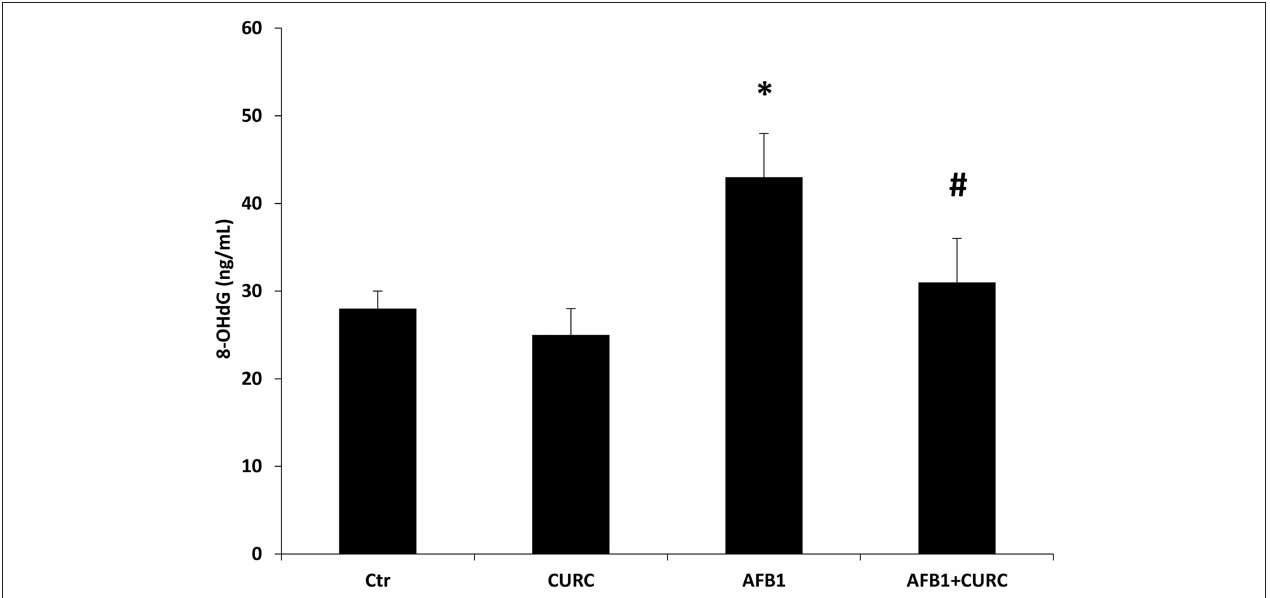
FIGURE 4 | 8-hydroxy-2 ′ -deoxyguanosine (8-OHdG) levels measured in broiler serum samples at the end of the treatment (T10). Ctr, control group; CURC, Curcumin group; AFB1, Aflatoxin B1 group; AFB1 + CURC, Aflatoxin B1 group plus Curcumin. Data are expressed as mean ± standard deviation (SD), n = 8 (* p < 0.05 vs. Ctr; # p < 0.05 vs. AFB1).